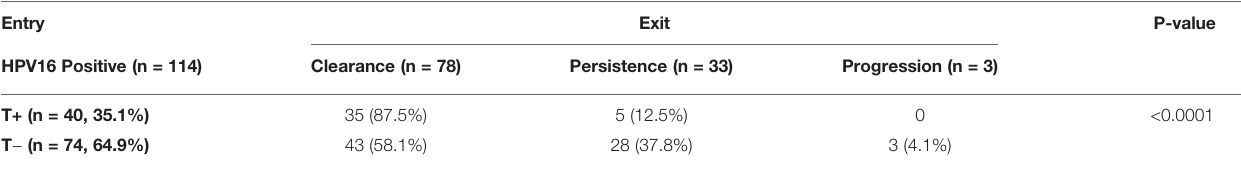
TABLE 5 | Clinical outcomes of patients with HPV16 E7-speci fi c T cell response.